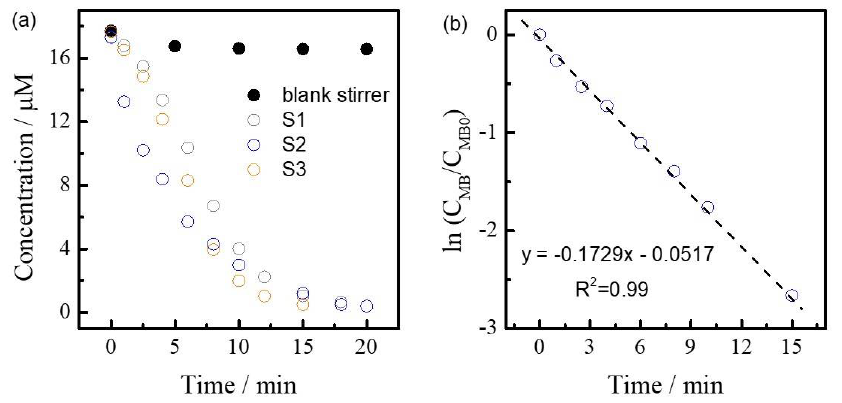
Figure 6. ( a ) Concentration vs. time curves of MB degradation with a non-impregnated and Fe- impregnated stirrer caps, and ( b ) fitting of MB degradation to a first order reaction kinetic model.